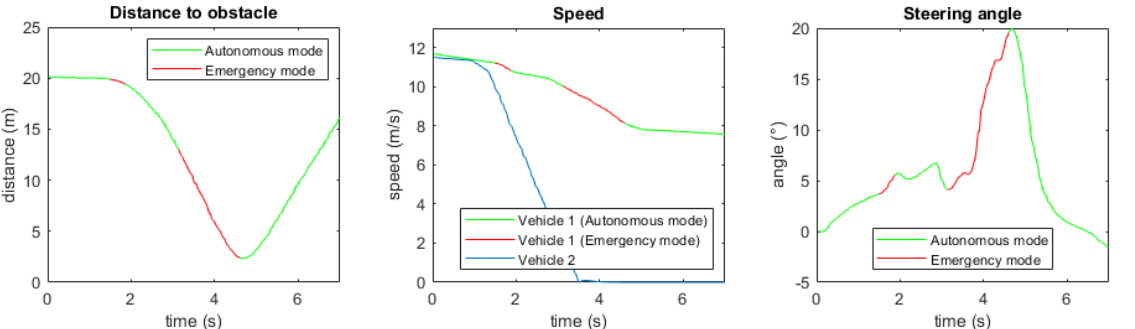
Figure 21. Parameters of ego vehicle in first scenario: distance to obstacle ( left ), speed ( middle ) and steering angle ( right ).